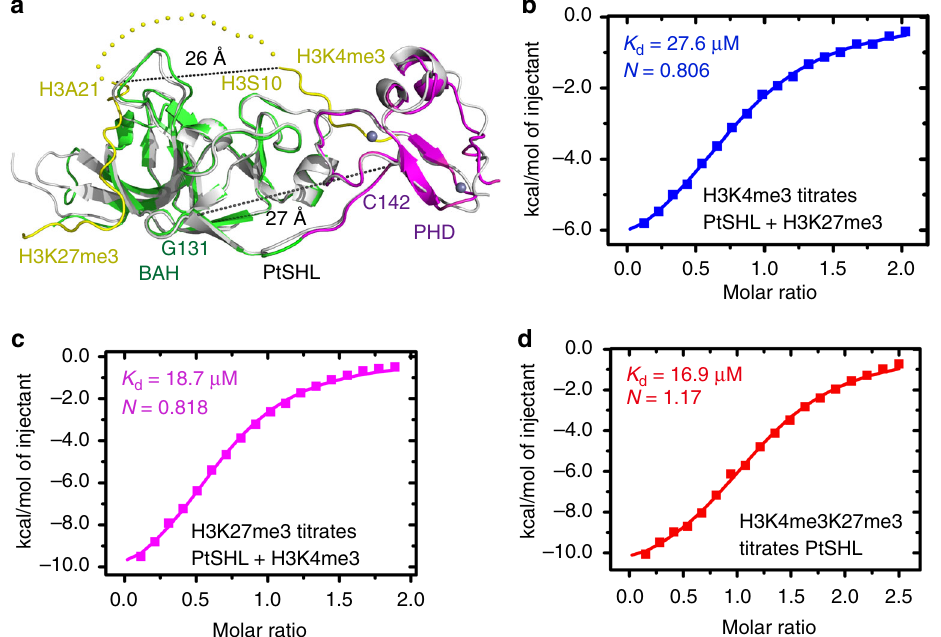
Fig. 4 H3K27me3-BAH and H3K4me3-PHD fi nger binding are independent of each other. a A superposition of PtSHL-H3K27me3 (in colored scheme) and PtSHL-H3K4me3 (in silver) complexes. The distance between H3S10 to H3A21 and the distance between Gly131 and Cys142 as a reference are highlighted as dashed lines. b The ITC binding curve of 2-fold excess H3(20-36)K27me3 pre-saturated PtSHL titrated by H3(1-15)K4me3 peptides. c The ITC binding curve of 2-fold excess H3(1-15)K4me3 pre-saturated PtSHL titrated by H3(20-36)K27me3 peptides. d The binding between PtSHL and H3(1-35) K4me3K27me3 peptide yielded a binding af fi nity nearly identical as PtSHL-H3K4me3 and PtSHL-H3K27me3 and with an N -value of